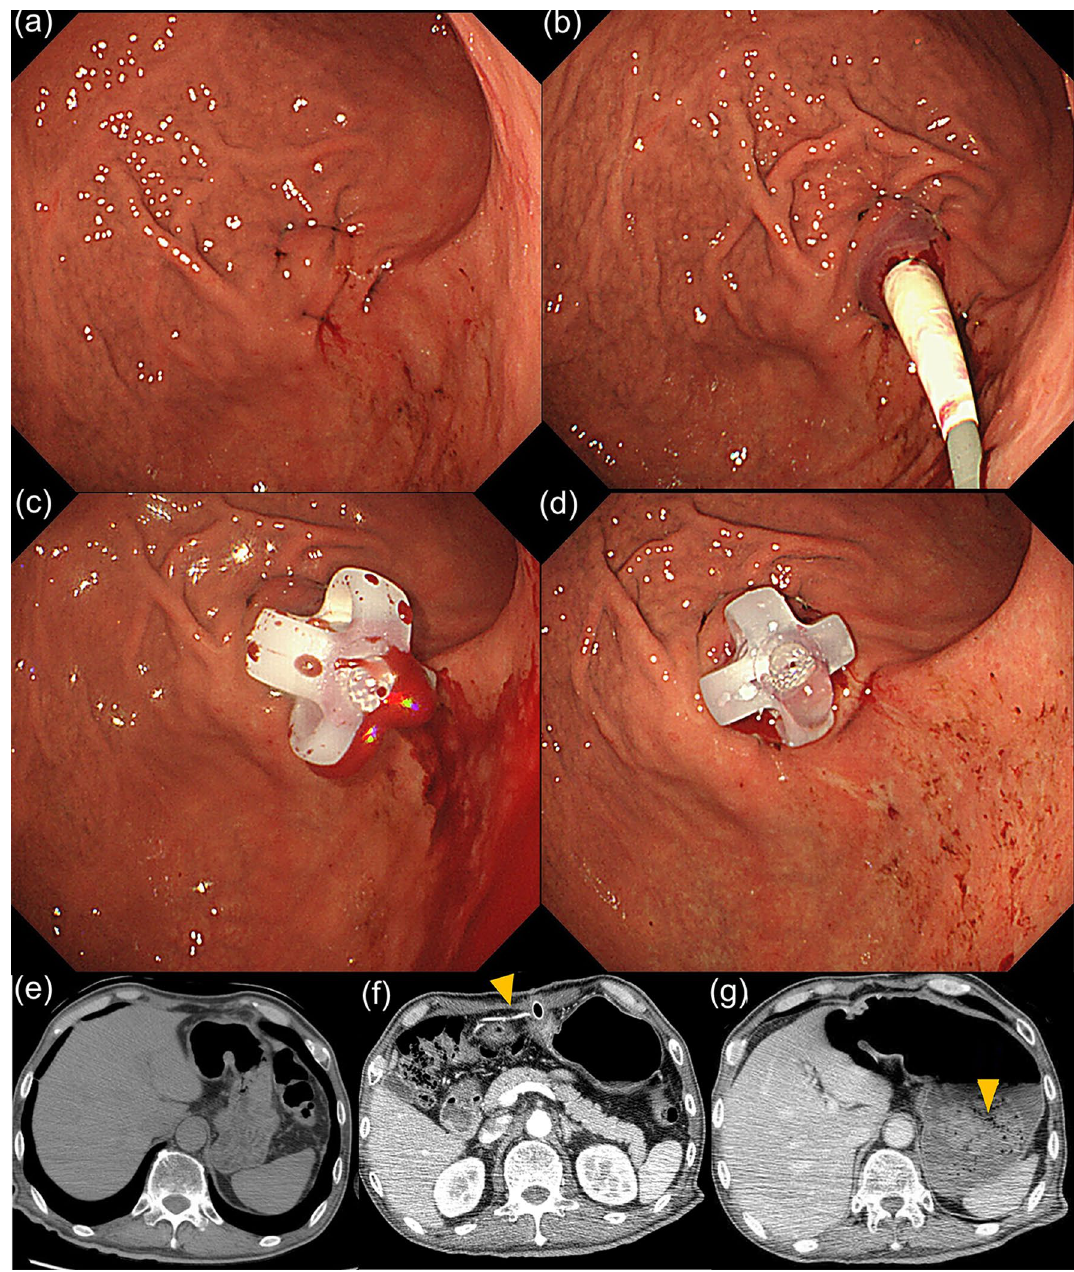
of gastrostomy tube insertion. ( d ) Compression hemostasis was performed by pulling on the tube for 10 min. ( e ) Before PEG construction, CT detected no interfering organs between the stomach and abdominal wall. ( f ) On postoperative day 11, an artery was found near the gastrostomy tube, but no intra-abdominal hemorrhage was observed (arrowheads). ( g ) On postoperative day 11, a hematoma was detected in the stomach